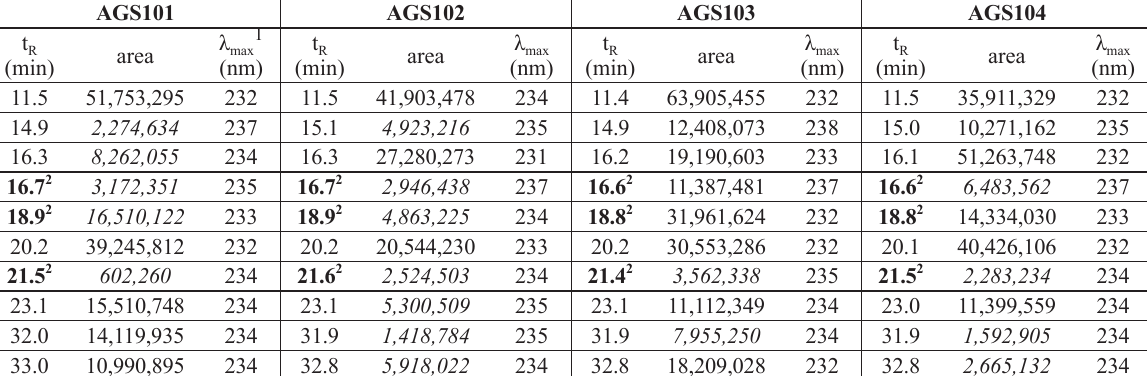
Data from HPLC analyses of specimens AGS101-104. Retention time, area and λ selected peaks (t > 10 min; area >10 7 in at least one specimen of the group) are R